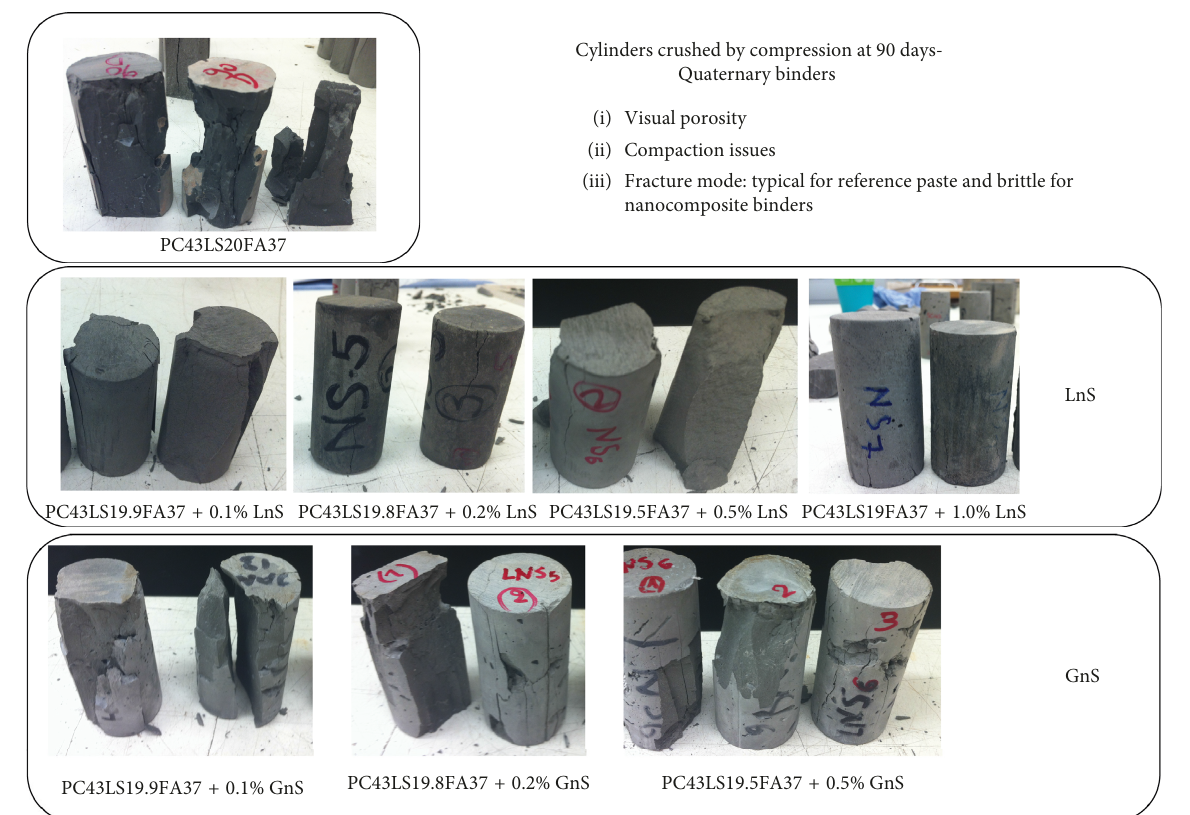
Figure 6: Crushed cylinders of LnS or GnS nanocomposite binders based on